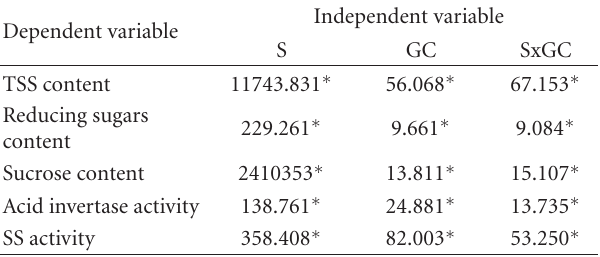
Table 1: Results of variance analysis (ANOVA) of stage (S), grafting combination (GC), and their interactions with total sugar content (TSS), reducing sugars content, sucrose content, acid invertase activity, and sucrose synthase activity (SS) in bark tissues of